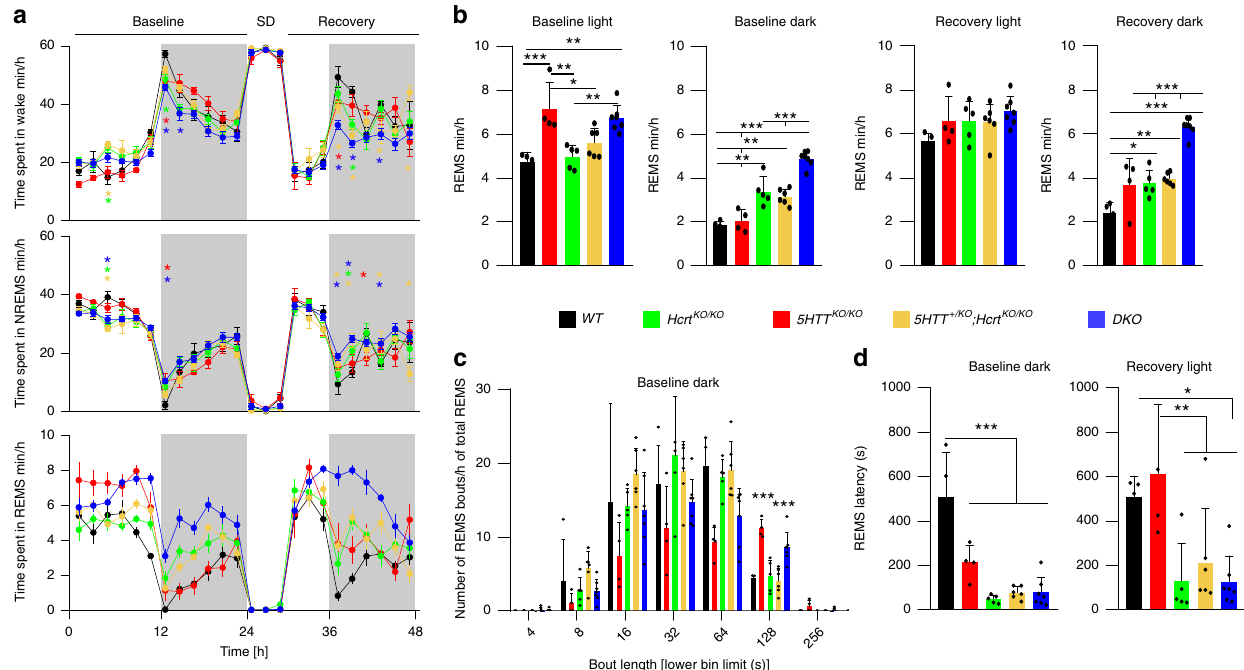
Fig. 1 Increased REMS time in 5HTT ko/ko mice and its regulation by HCRT. a Time-course of vigilance states; Wakefulness (top), NREMS (middle) and REMS (bottom). 5HTT KO/KO mice show a large increase in REMS amount during the light period, while Hcrt KO/KO and DKO mice show a large increase in the dark period both at baseline and during recovery (two-way ANOVA, time × genotype F (92,483) = 2.94 (wakefulness), 2.37 (NREMS) and 4.64 (REMS), P < 0.0001, followed by Dunnett ’ s test, WT vs 5HTT + /KO ;Hcrt KO/KO *, DKO *, 5HTT KO/KO *, Hcrt KO/KO *, P < 0.05). Data points are shown in minutes per hour and represent the average of 2 h. Baseline represents the average of the 2 recording days that preceded sleep deprivation (SD). b From left to right: the total amount of REMS during baseline light, dark and recovery light and dark periods (one-way ANOVA, genotype F (4,21) = 10.6, 41.80, 1.89, and 30.70, respectively, P = 0.14 for recovery light and P < 0.0001 for the rest, followed by Tukey test). c Distribution of REMS bout durations indicates signi fi cantly longer bouts in 5HTT KO/KO and DKO mice. Lower numbers for each bout duration bin are presented on the x axis (one-way ANOVA, genotype F (4, 21) = 15.03, P < 0.0001, followed by Tukey test). d REMS latency is dramatically decreased in genotypes carrying a mutant Hcrt allele, both in baseline dark period and immediately after SD (one-way ANOVA, genotype F (4, 21) = 19.74 (baseline dark, P < 0.0001) and 6.31 (recovery light, P < 0.002) followed by Tukey test). * P < 0.05; ** P < 0.01; *** P < 0.001 for ( b – d ). Values are mean ± SD. DKO : n = 7, 5HTT KO/KO : n = 4, Hcrt KO/KO : n = 5, 5HTT + /KO ;Hcrt